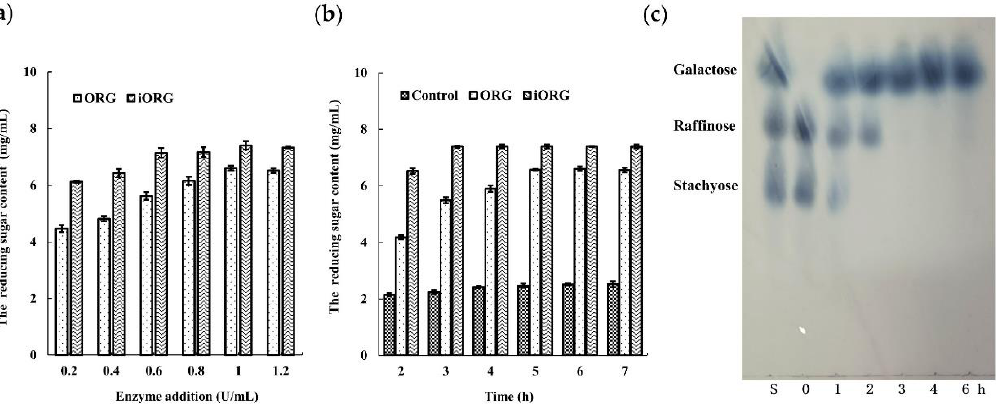
Figure 9. ( a ): The released reducing sugar content from soymilk by varied enzyme dosage of ORG and iORG after 5 h of incubation at 50 °C; ( b ): the released reducing sugar content from soymilk at different incubation times after treatment with ORG or iORG; ( c ): TLC analysis of hydrolysis products from soymilk after treatment with iORG. Lane S, a mixture of galactose, raffinose, and stachyose. Control (0 h) indicates without ORG or iORG treatment.